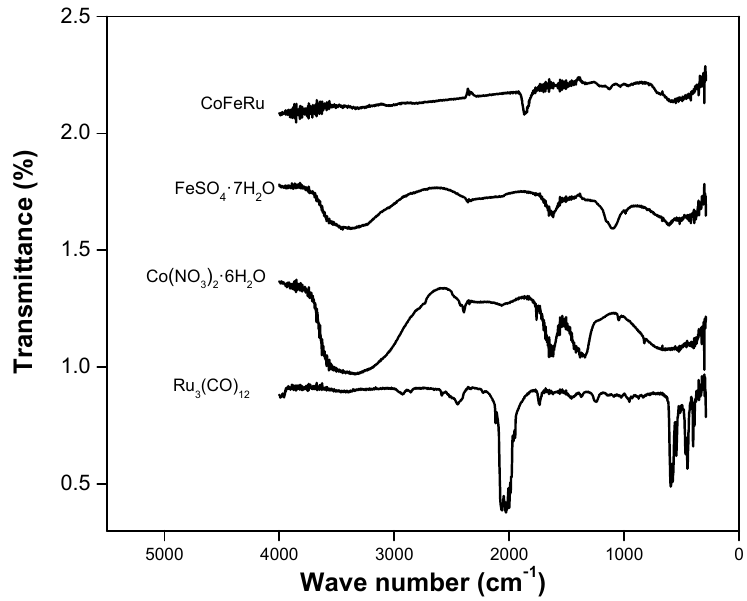
Figure 3. FT-IR spectra of the unsupported CoFeRu electrocatalyst and precursors.